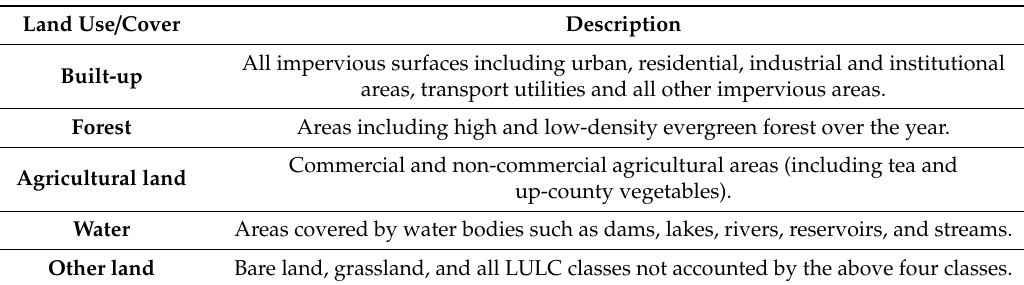
Table 2. Description of the LULC classes used for